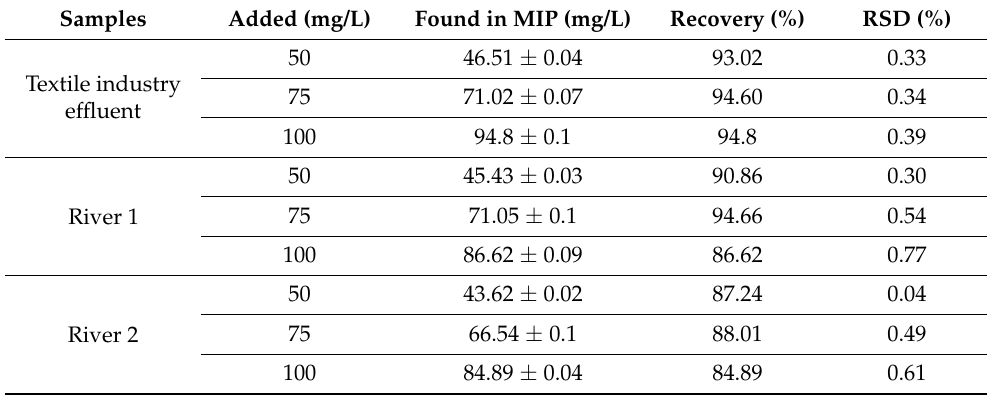
Table 6. Recovery test of the MIP using different samples in a province of Pakistan (KPK).